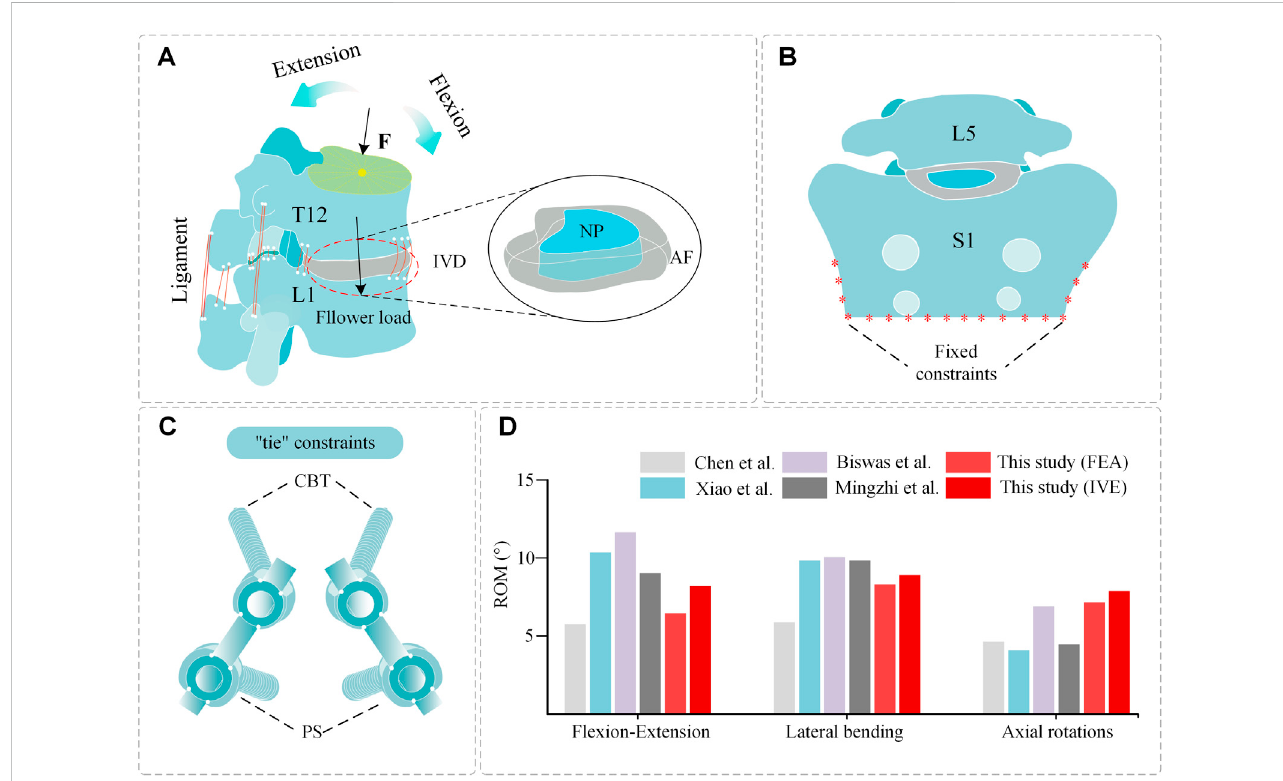
FIGURE 4 Spinal composition, constraint setting, and validation. (A) Spinal constraint setting: compression force F, follower load. (B) Spinal constraint setting: S1 fi xed constraints. (C) Hybrid placement of screws and “ tie ” constrains. (D) Comparison of ROM, between this study and the results reported in the previous